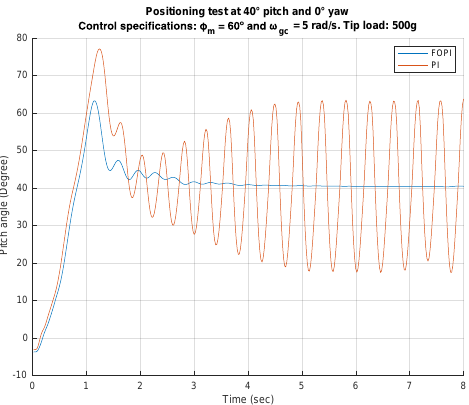
Figure 15. FOPI and PI controller ( φ m = 60 ◦ and ω gc = 5 rad/s) response to α = 40 ◦ and β = 0 ◦ with 500 g mass at the